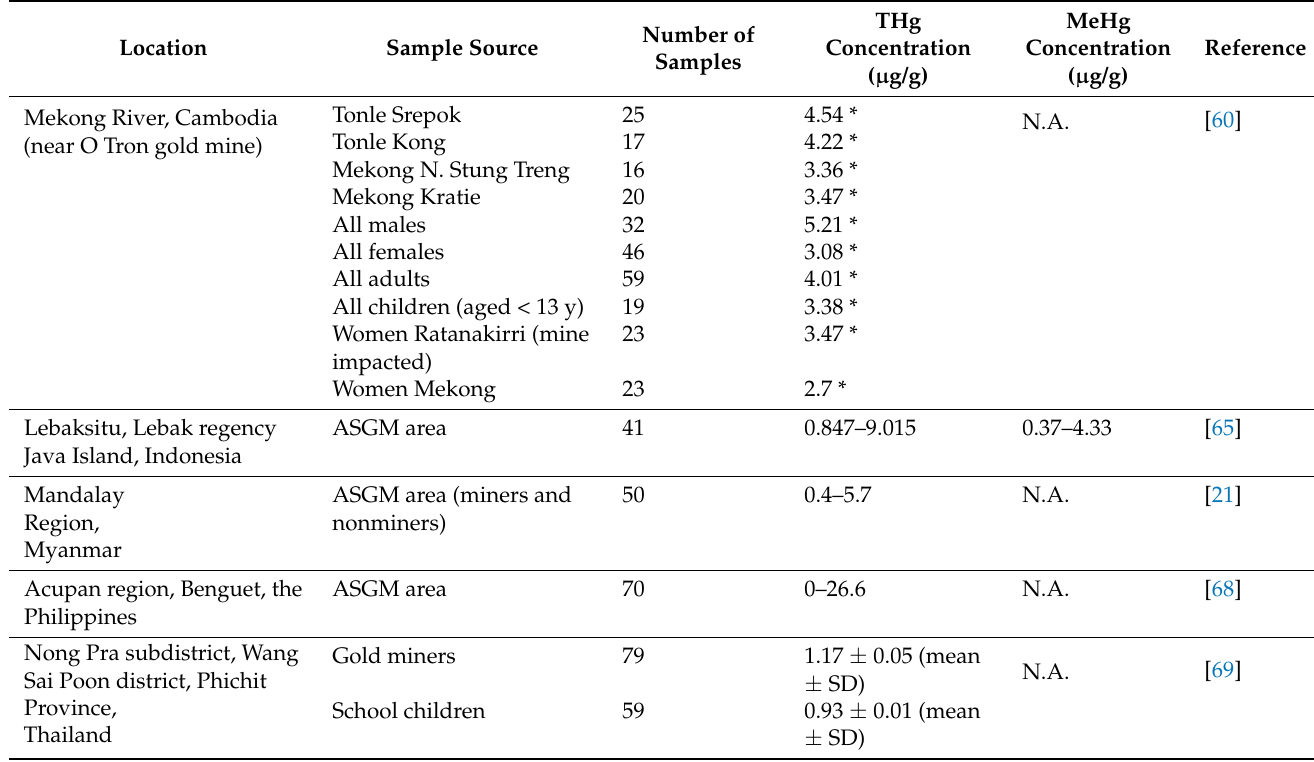
Table 4. Summary of Hg concentrations in human hair from Cambodia, Indonesia, Myanmar, the Philippines, and